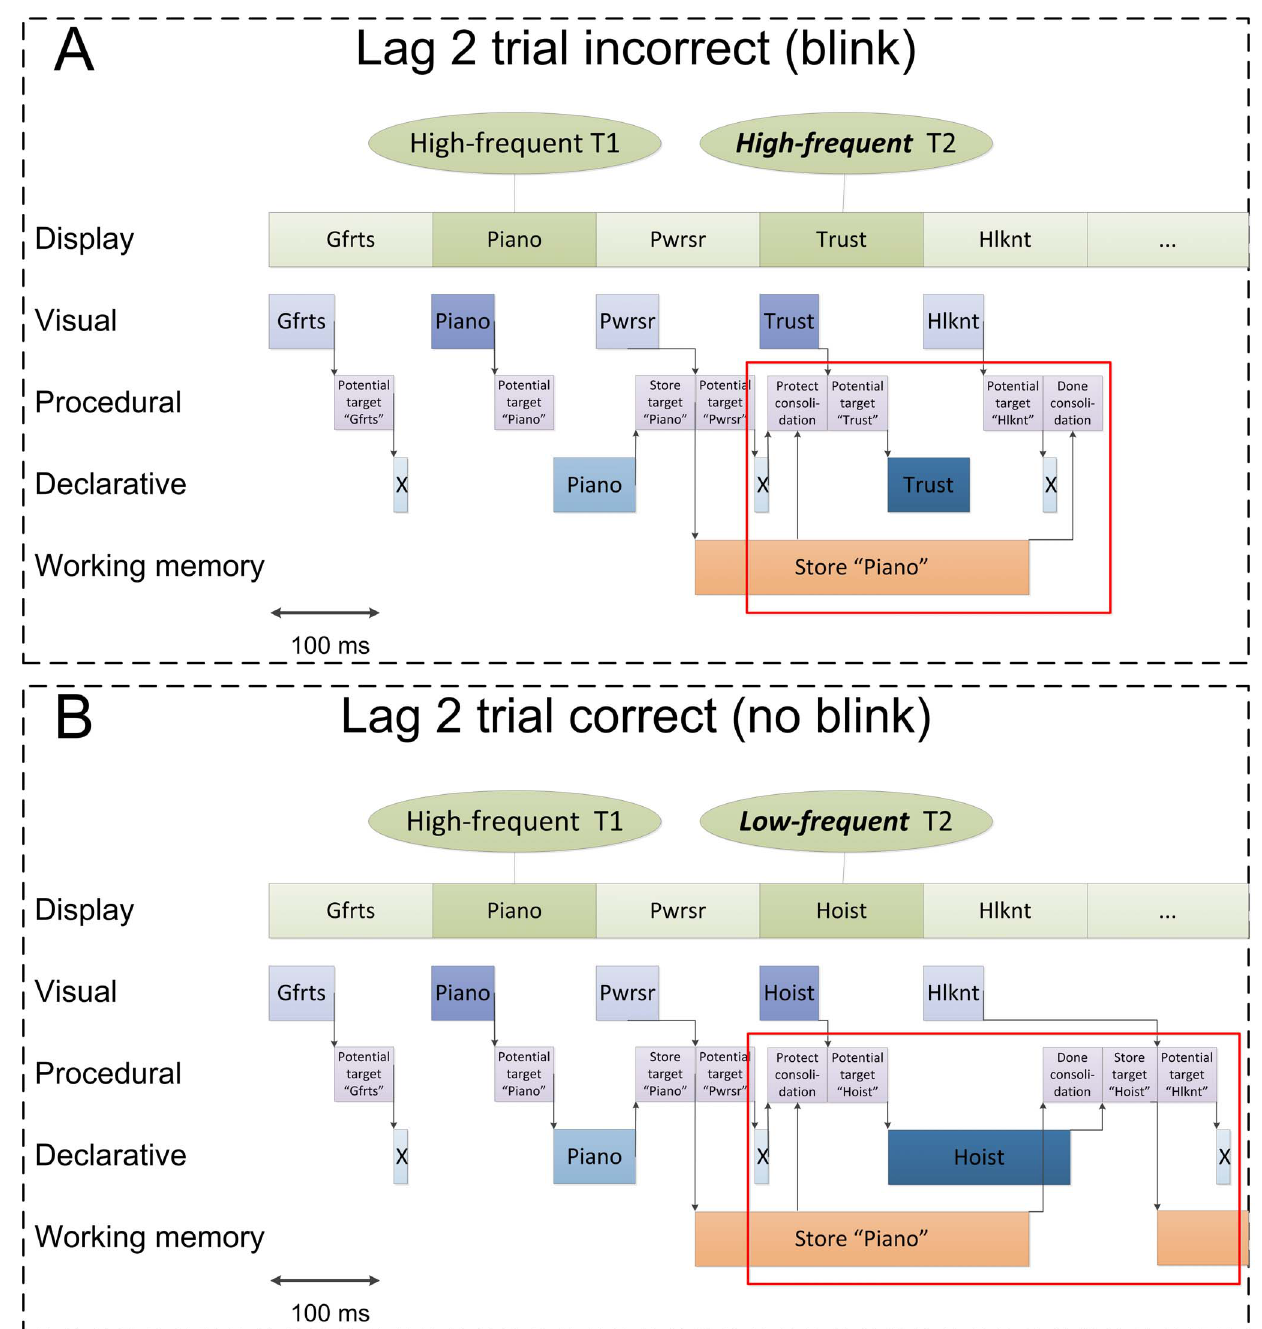
Figure 4. Examples of the model traces for the HFHF-condition (a) and the HFLF-condition (b). The second target was presented at lag 2.